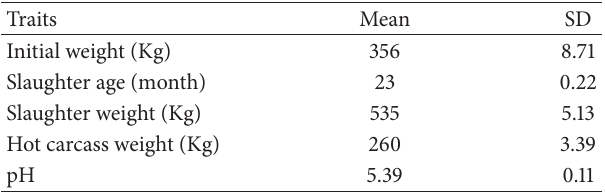
Table 1: Characteristics of the slaughtered bulls.